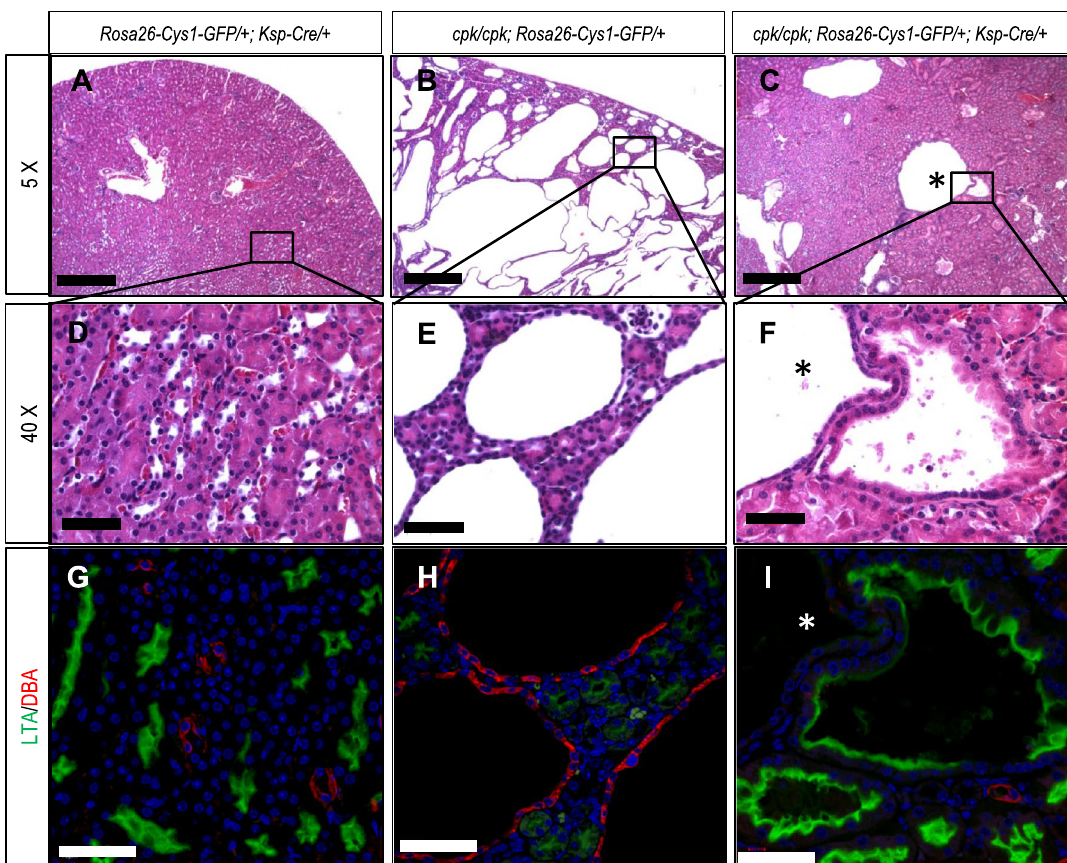
Figure 3. Overall attenuation of renal cystic phenotype in cpk rescue mice, and sporadic proximal tubule cyst formation. Formalin fixed, paraffin embedded 5 µm sections of kidney tissues from 6-week-old mice of the indicated genotypes were stained with H&E and examined by light microscopy ( A – F ) or stained with lectins LTA (green, proximal tubules) or DBA (red, distal tubules) and examined by immunofluorescence microscopy ( G , H , I ). Panels ( A – C ) are ×5 magnification with scale bars equal to 200 µm. Boxed areas are shown at ×40 magnification in corresponding panels ( D – F ) with scale bars equal to 50 µm. Lectin staining was performed on serial sections corresponding to H&E stained samples. Cell nuclei were stained with DAPI. Scale bars in panels ( G – I ) are equal to 50 µm. The asterisk (*) identifies a large cyst that was not stained by either LTA or DBA. Images are representative of tissue sections from 3 (Fig. 3A–F). Using DBA and LTA lectins, markers of distal and proximal tubules, respectively 39,40 , we observed